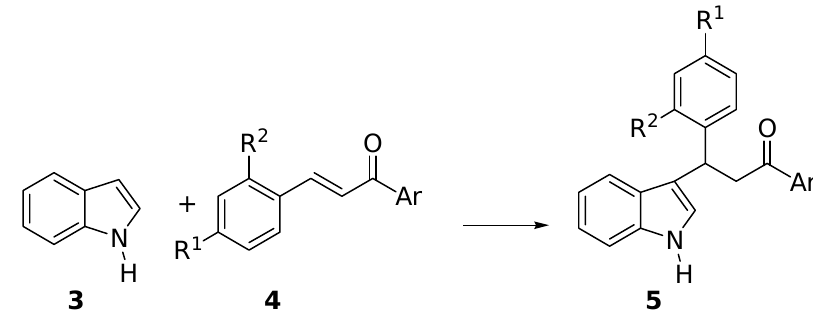
Figure 1 . Chiral H -BINOL-based phosphoric acid ( S ) -1 and BINOL-phosphoric acid ( R ) -2 8